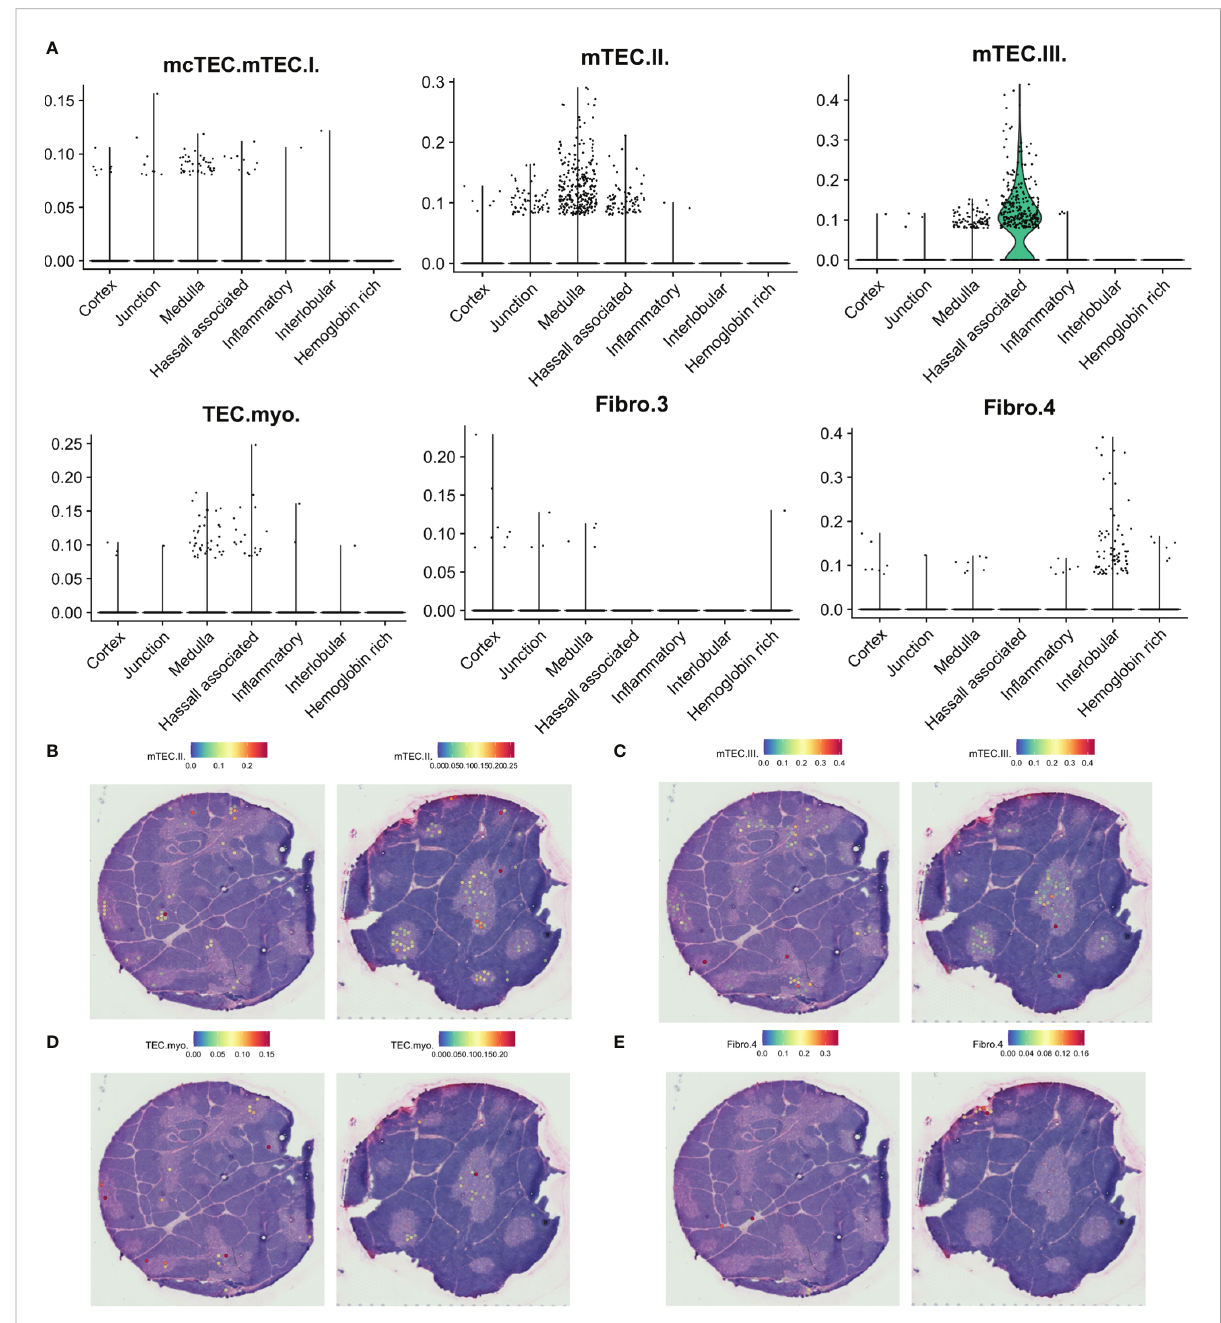
FIGURE 8 Predicted localisation of selected stromal cell populations by SPOTlight. (A) . Predicted proportion of selected populations among tissue spots. (B – E) . Localisation of spots predicted to include selected cell populations on representative tissue